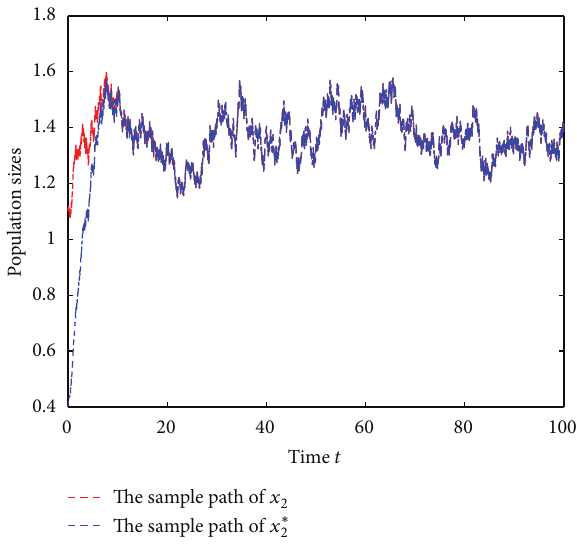
Figure 2: The sample paths of 𝑥 2 (𝑡) and 𝑥 ∗ 2 (𝑡) .